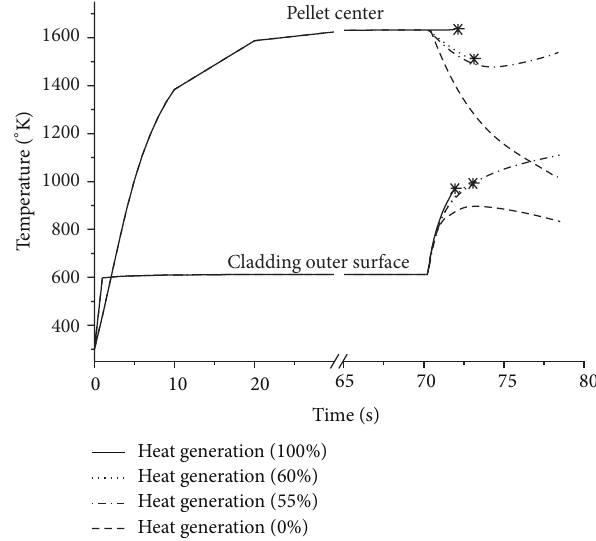
Figure 10: Temperatures changes at pellet center and cladding outer surface after LOCA at 70